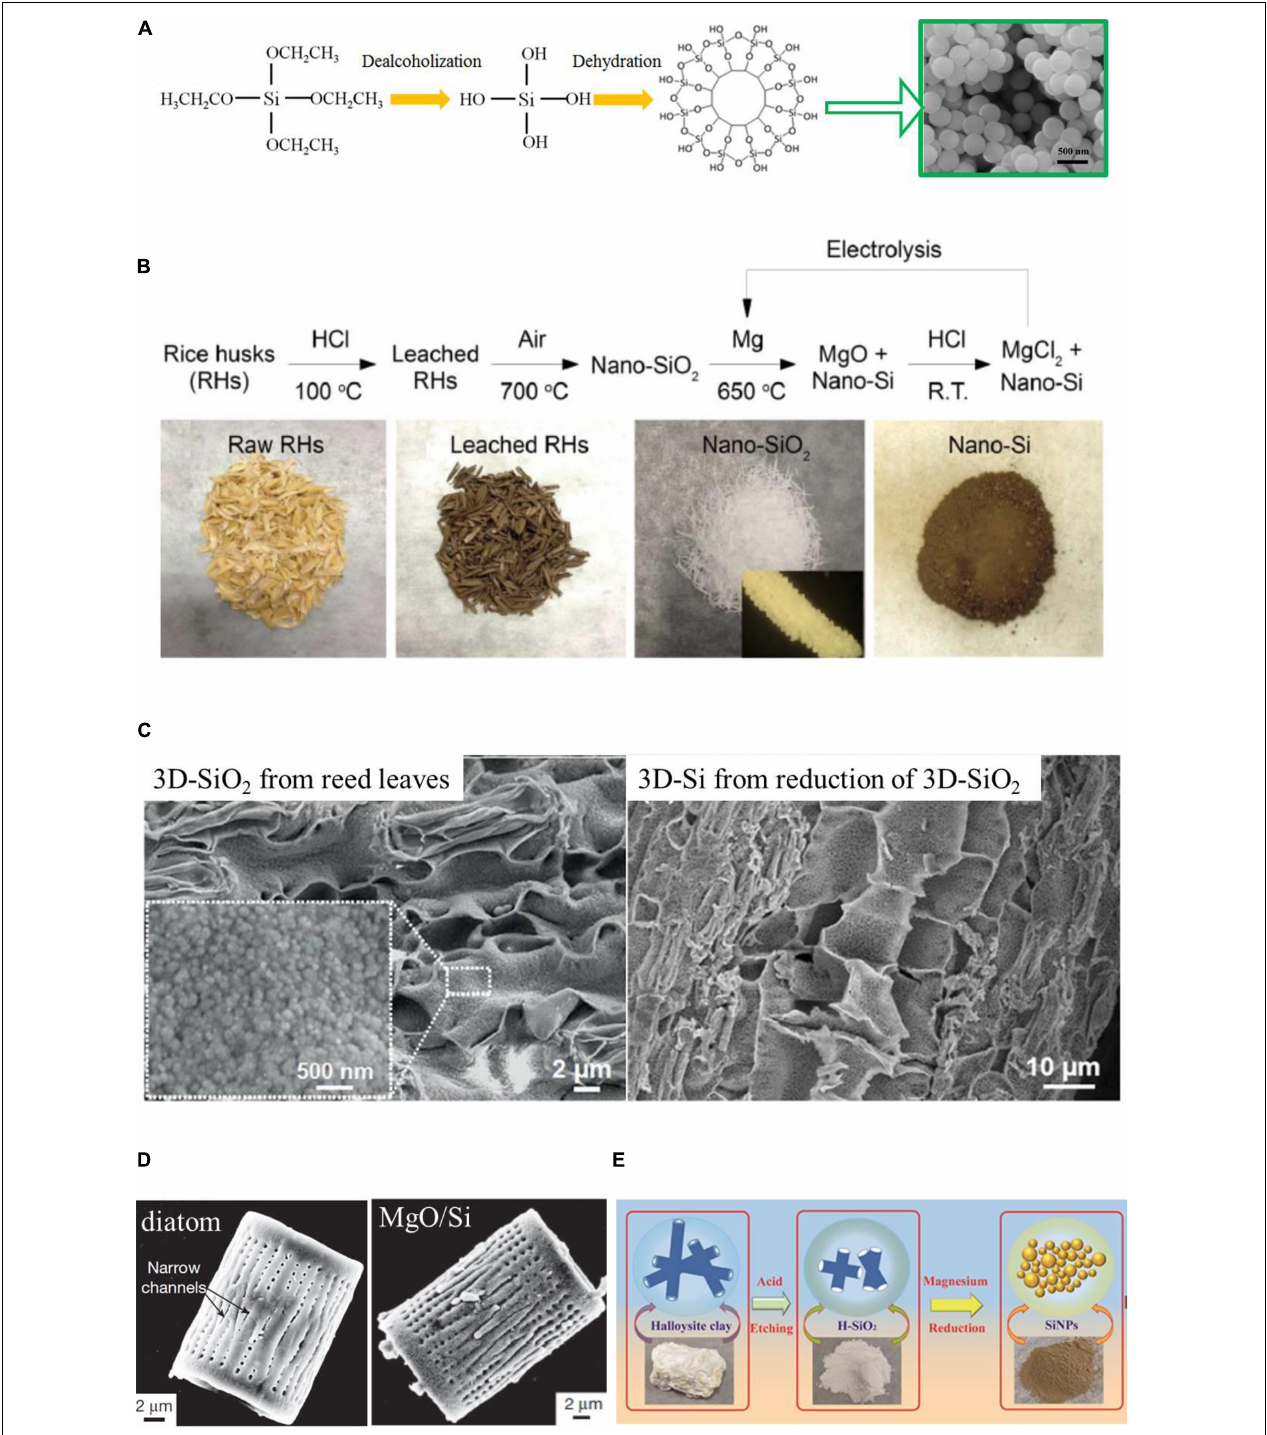
FIGURE 4 | (A) Schematic of TEOS hydrolyses and condenses to form silica and SEM images of the prepared SiO 2 . (B) Flow chart of the process for recovering SiNPs from rice husk and the optical images of the intermediate substances. Reprinted from Ref. (Liu et al., 2013), with the permission of Springer Nature. (C) SEM image of highly porous and 3D hierarchical microstructures of SiO 2 from reed leaves and the received Si. Reprinted from Ref. (Liu et al., 2015), with the permission of John Wiley and Sons. (D) SEM images of diatom and the MgO/Si composition from reduction of diatom SiO 2 . Reprinted from Ref. (Bao et al., 2007), with the permission of Springer Nature. (E) Schematic illustration of producing SiNPs from the halloysite preparation process. Reprinted from Ref. (Sainan et al., 2018), with the permission of MDPI.